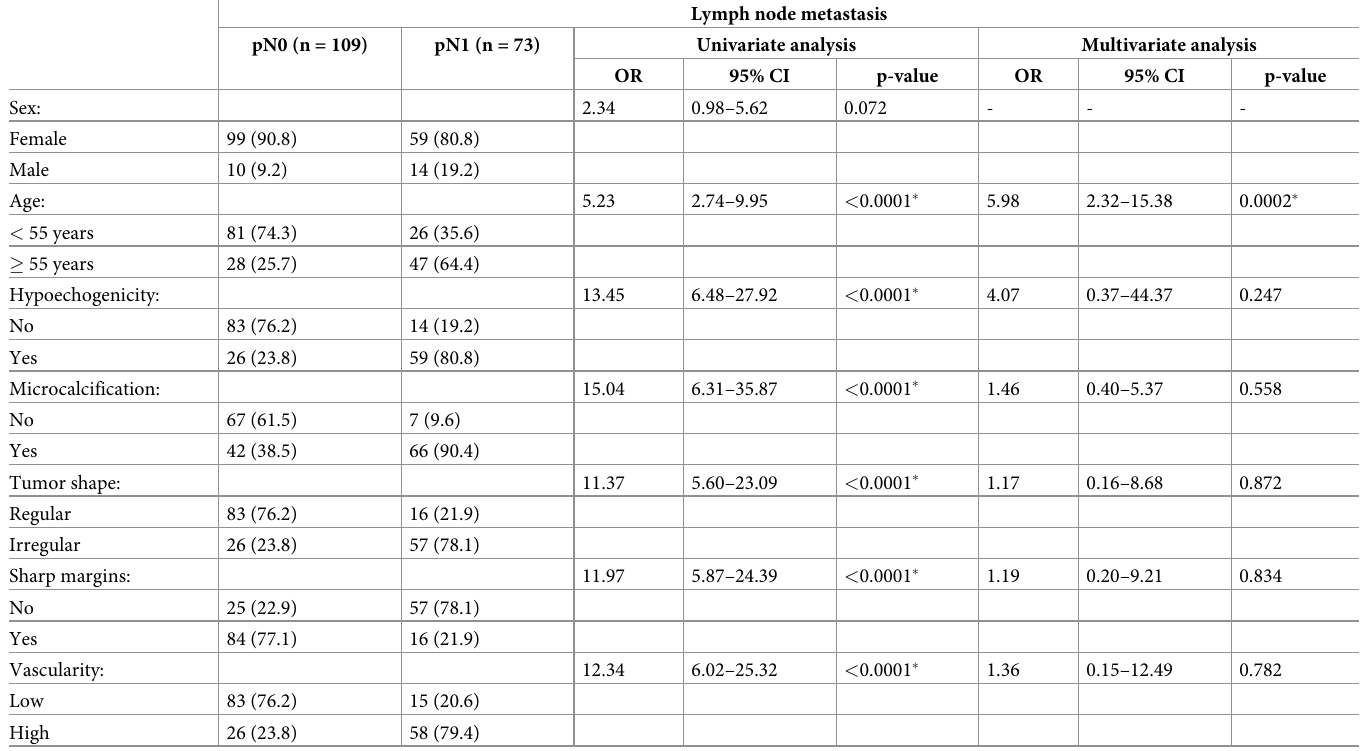
Table 6. Univariate and multivariate logistic regression analyses of demographic and ultrasound features as risk factors for LNM in PTMC